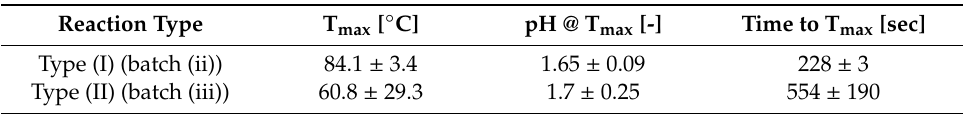
Table 4. The reaction di ff erence for type I and II Fenton reaction when using 100 mL Erlenmeyer flasks on the aluminum bench for heat